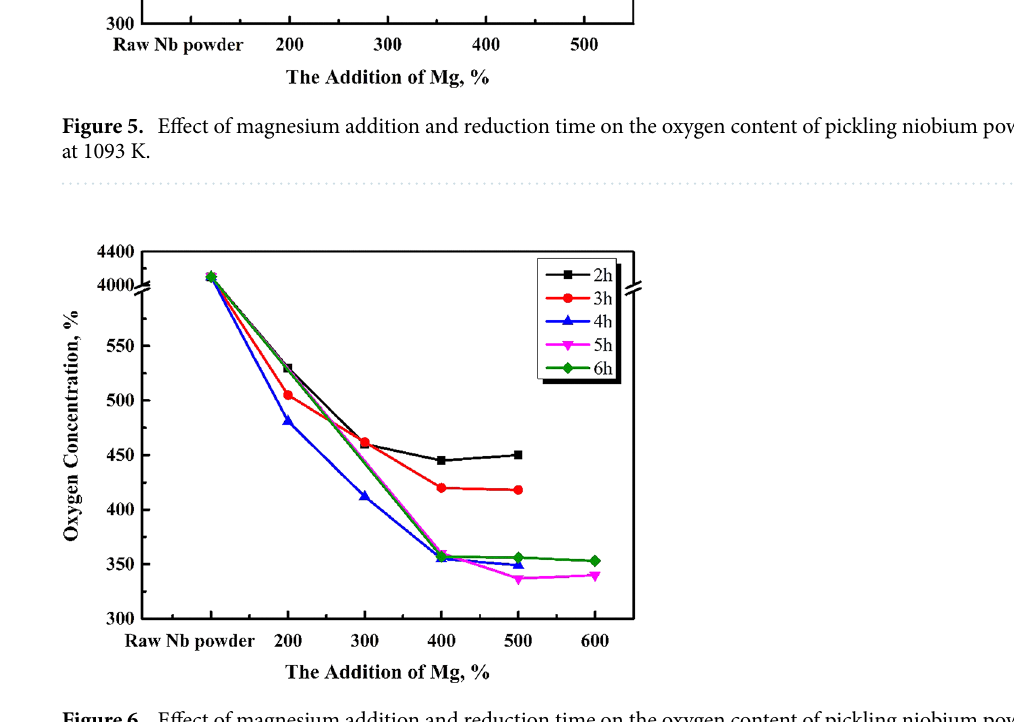
Figure 6. Effect of magnesium addition and reduction time on the oxygen content of pickling niobium powder at 1133